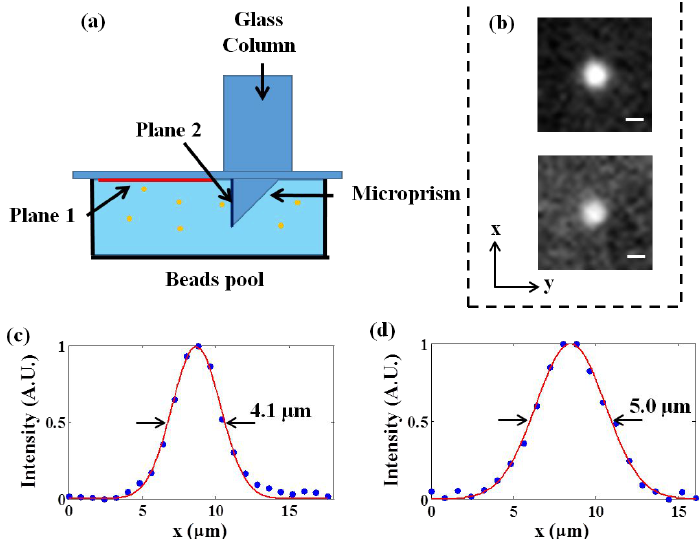
Figure 2. Characterization of the imaging system. ( a ) The scheme of imaging fluorescent microspheres. ( b ) The experimental PSFs in the horizontal plane of Plane 1 (upper) and Plane 2 (lower). Scale bar: 3µm. ( c , d ) Lateral intensity profiles of the fluorescent microspheres on Plane 1 and Plane 2, respectively.